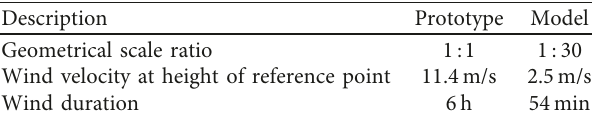
Table 3: Experimental parameters of prototype and experiments.